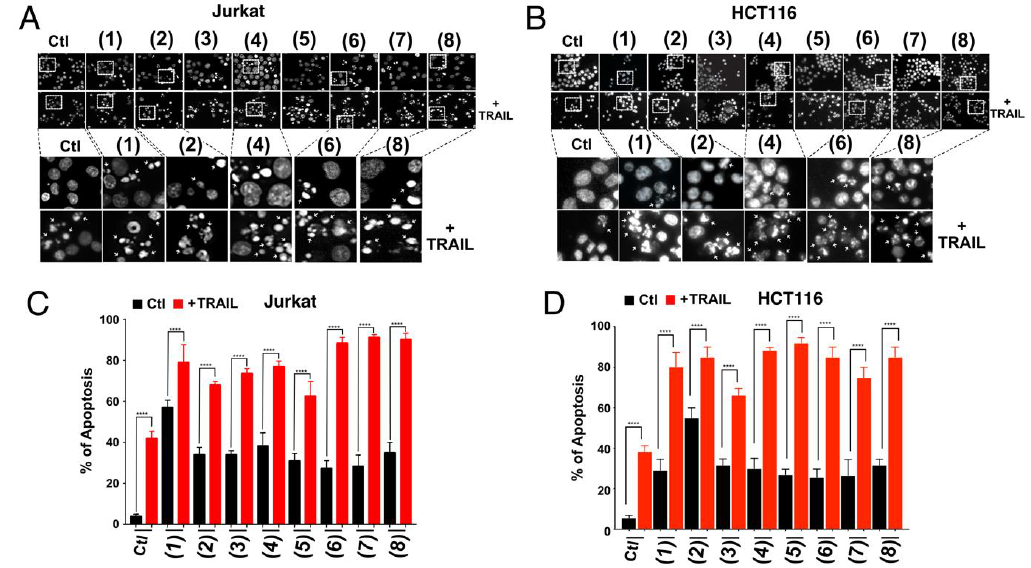
Figure 4. Characterization of apoptosis induced by marine-derived compounds with and without TRAIL in Jurkat and HCT116 cells. ( A , B ) Cells were treated with 50 µ M of the indicated compounds for 6 h in the absence and in the presence of TRAIL (250 ng) and stained with the fluorescent DNA-binding dye Hoechst 33342. Morphological changes ( A , B ) were detected under fluorescent microscope using a blue filter. Corresponding quantifications are shown in ( C , D ). All values are presented here as ± SD (n = 3). Significance was evaluated by two-way ANOVA. **** p < 0.0001.